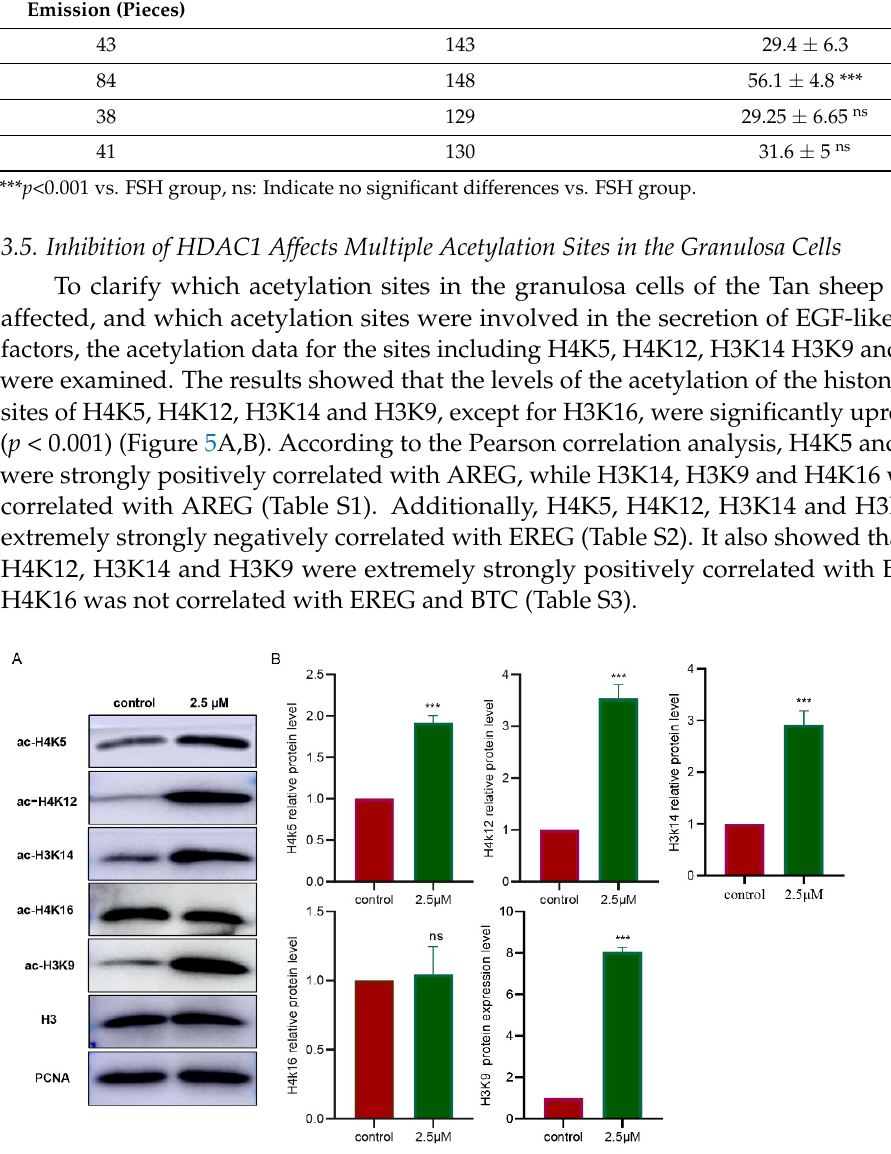
Figure 5. Inhibition of HDAC1 affected the expression of acetylated histones in the cultured granu- losa cells. ( A , B ): Changes in acetylation sites of different histones detected by Western blotting as- says. *** p < 0.001. Pyroxamide: specific inhibitor of HDAC1. n = 3. ns: Indicate no significant differ- ences